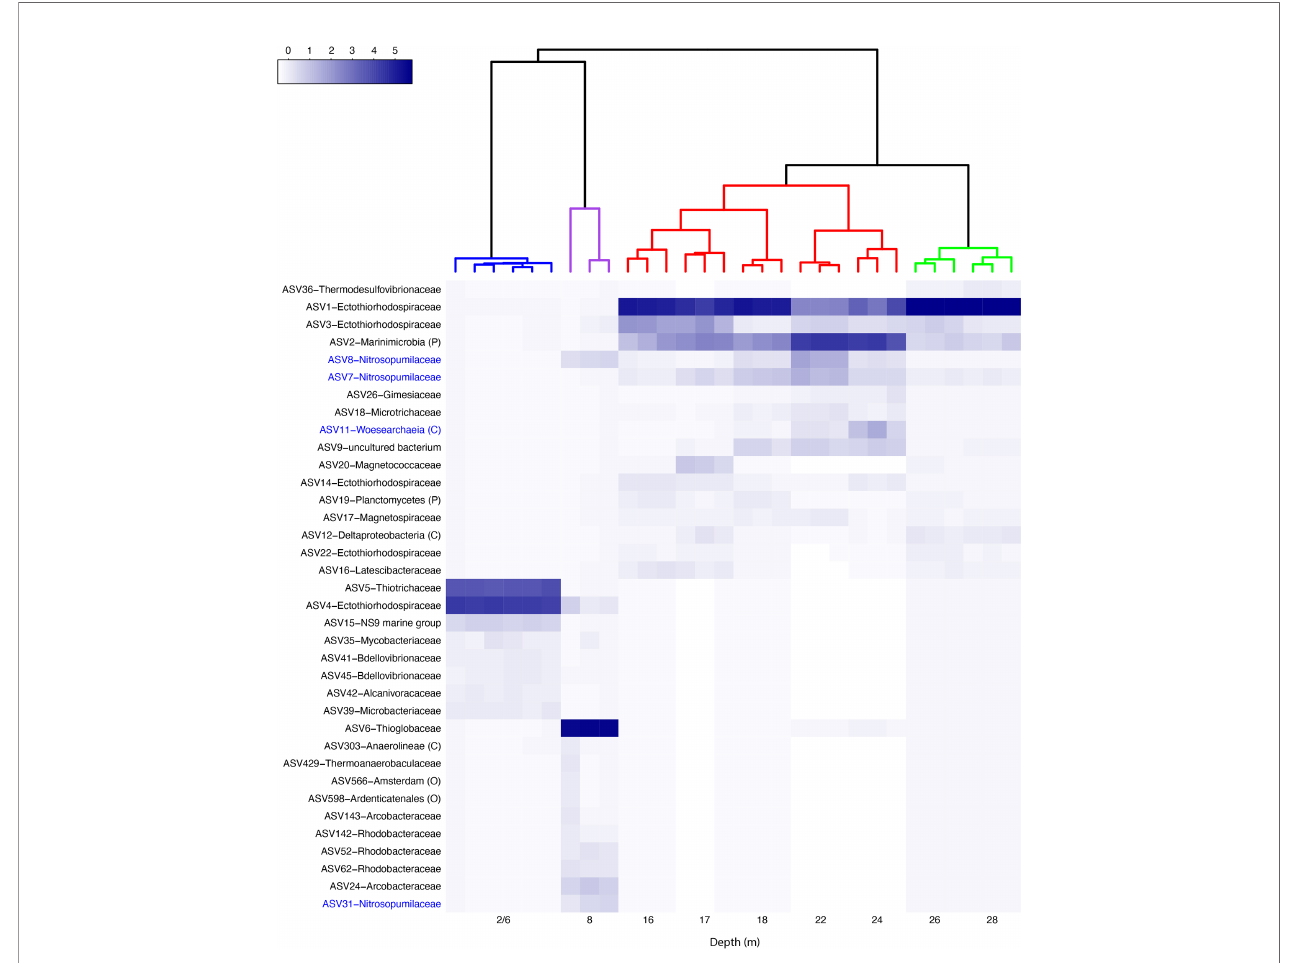
FIGURE 6 | Heatmap and dendrogram based on Bray Curtis dissimilarity matrix. The 36 ASVs visualised are present in at least one sample at a relative abundance greater than 2%. The coloured clusters are supported by PERMANOVA ( Supplementary Table 5 ) with the exception of the 8 m replicates, which were not signi fi cantly different based on this analysis. Dendrogram based on Bray-Curtis distance metric hierarchical clustering of ASV relative abundance for each replicate sample (2 and 6 m were not distinguishable from each and are shown as one cluster). The family name is shown after the ASV designation where that has been determined, otherwise the lowest taxonomic ranking obtained is shown (O – Order, C – Class, P – Phylum). Archaeal ASVs ’ labels are blue. Relative abundance values are in Supplementary Table 6D